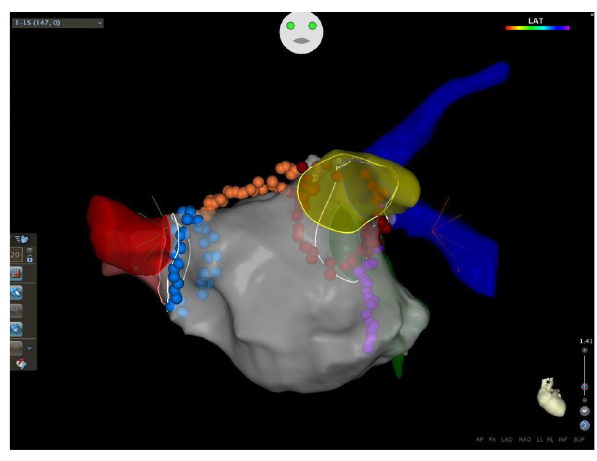
Fig. 2. Remote magnetic navigation-guided catheter ablation. 3D electro-anatomical map of the left atrium during ablation of persistent atrial fibrillation using system CARTO® 3 from antero-posterior view. Red and blue dots highlight circular radio- frequency ablation lesions around the left and right pulmonary veins respectively, orange dots highlight roof ablation line and violet dots highlight mitral isthmus